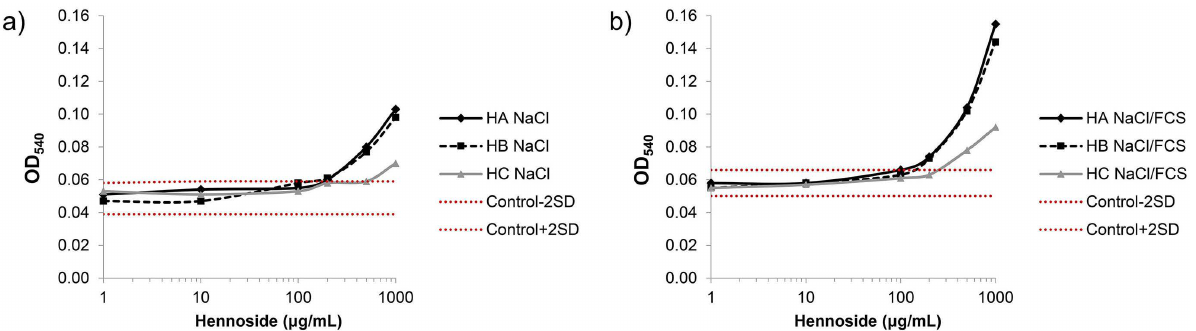
Figure 3. Hennoside-induced lysis of erythrocytes resuspended in ( a ) 0.9% NaCl and ( b ) 0.9% NaCl containing 10% FCS (NaCl/FCS). The hemolysis was followed based on the optical density at 540 nm (OD 540 ) values of supernatants obtained after centrifugation of erythrocyte suspension. HA—hennoside A; HB—hennoside B; HC—hennoside C; NaCl—hennosides and erythrocytes diluted in 0.9% NaCl; NaCl/FCS—hennosides and erythrocytes diluted in 0.9% NaCl containing 10% FCS. Red lines indicate mean − 2SD (control − 2SD) to mean + 2SD (control + 2SD) range of control i.e., spontaneous lysis of erythrocytes incubated in 0.9% NaCl ( a ) and ( b ) 0.9% NaCl/FCS without hennosides.